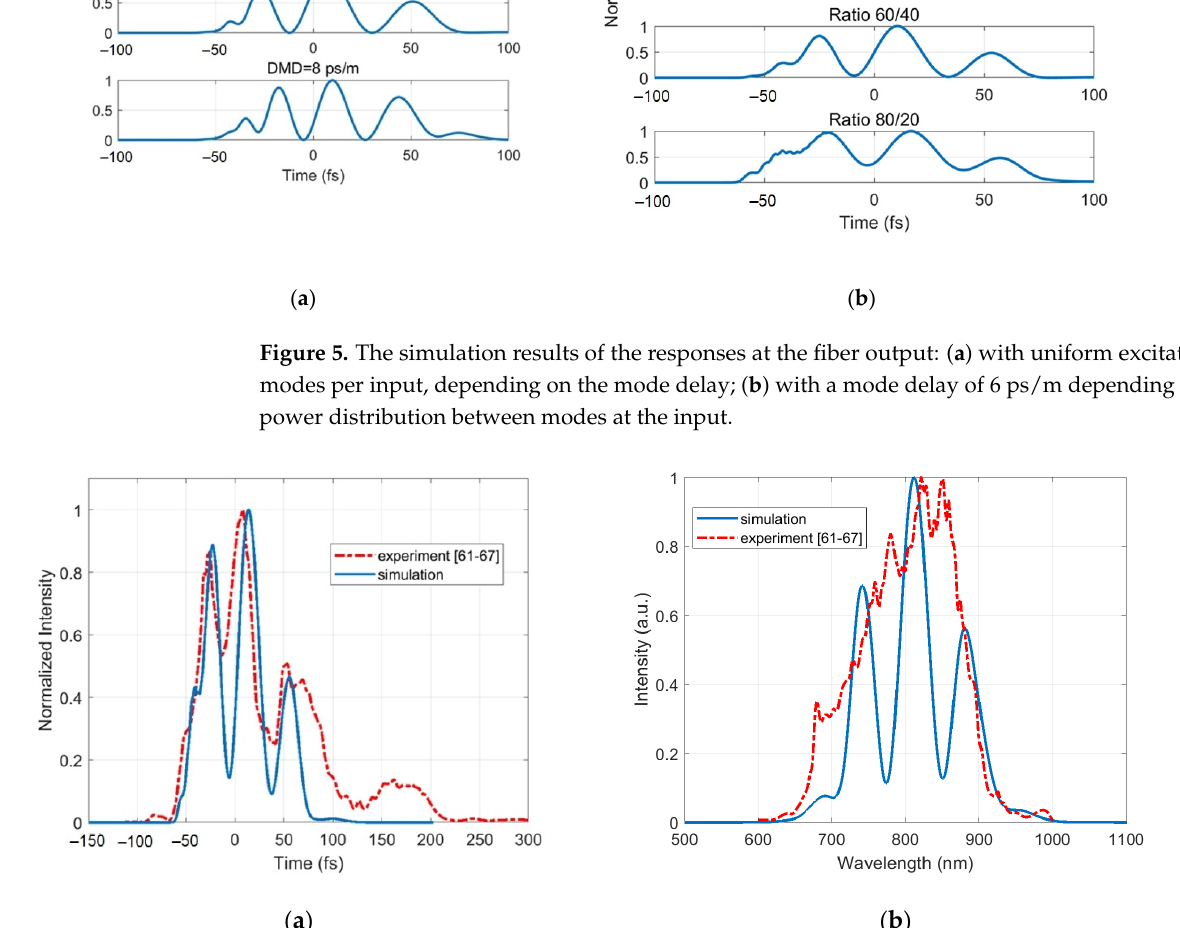
Figure 6. The simulation results: ( a ) impulse response; ( b ) spectral characteristic.